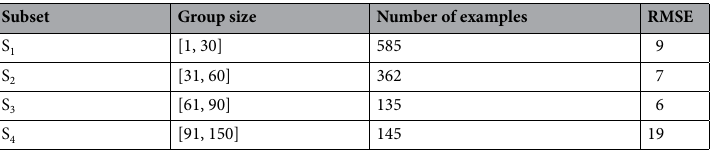
Table 2. Results of RF analysis in terms of RMSE obtained on the subsets of S. The performances of the RF models were evaluated in terms of RMSE trained on the S1, S2, S3, and S4 datasets using five runs of the cross- validation